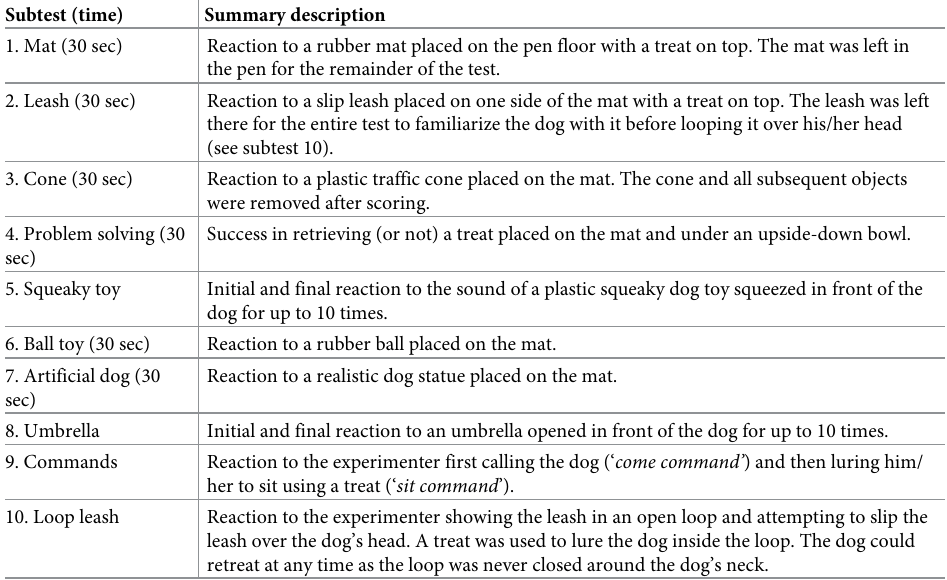
Table 2. Summary description of the subtests included in the reactivity test. A more detailed description of the test protocol and scoring system is presented in Section 4 in S1